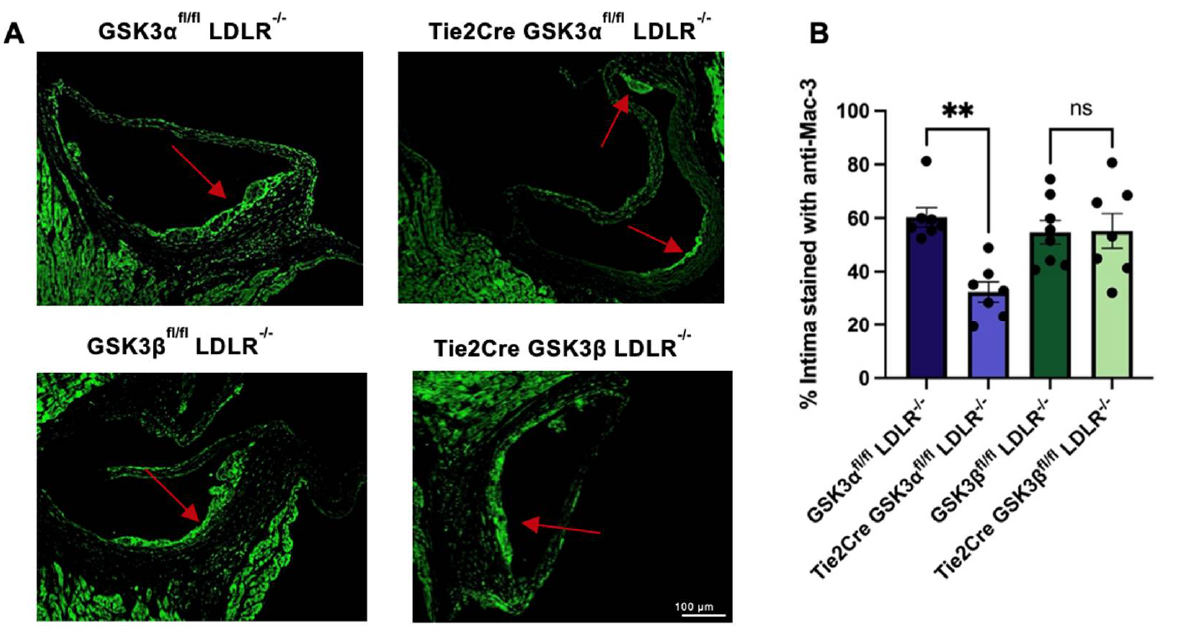
Figure 3. Monocyte/macrophage recruitment in endothelial/macrophage GSK3 α / β knockout mice. ( A ) Representative images of cross sections of aortic sinus from 15 week old endothelial/macrophage GSK3 α / β knockout and control mice stained with an antibody against Mac-3. Scale bar represents 100 µ m. Red arrow indicates atherosclerotic plaque. ( B ) Quantification of percentage of the intima stained with anti-Mac-3 antibody. n = 7–8 ( B ), ** p < 0.005. ns = not significant.